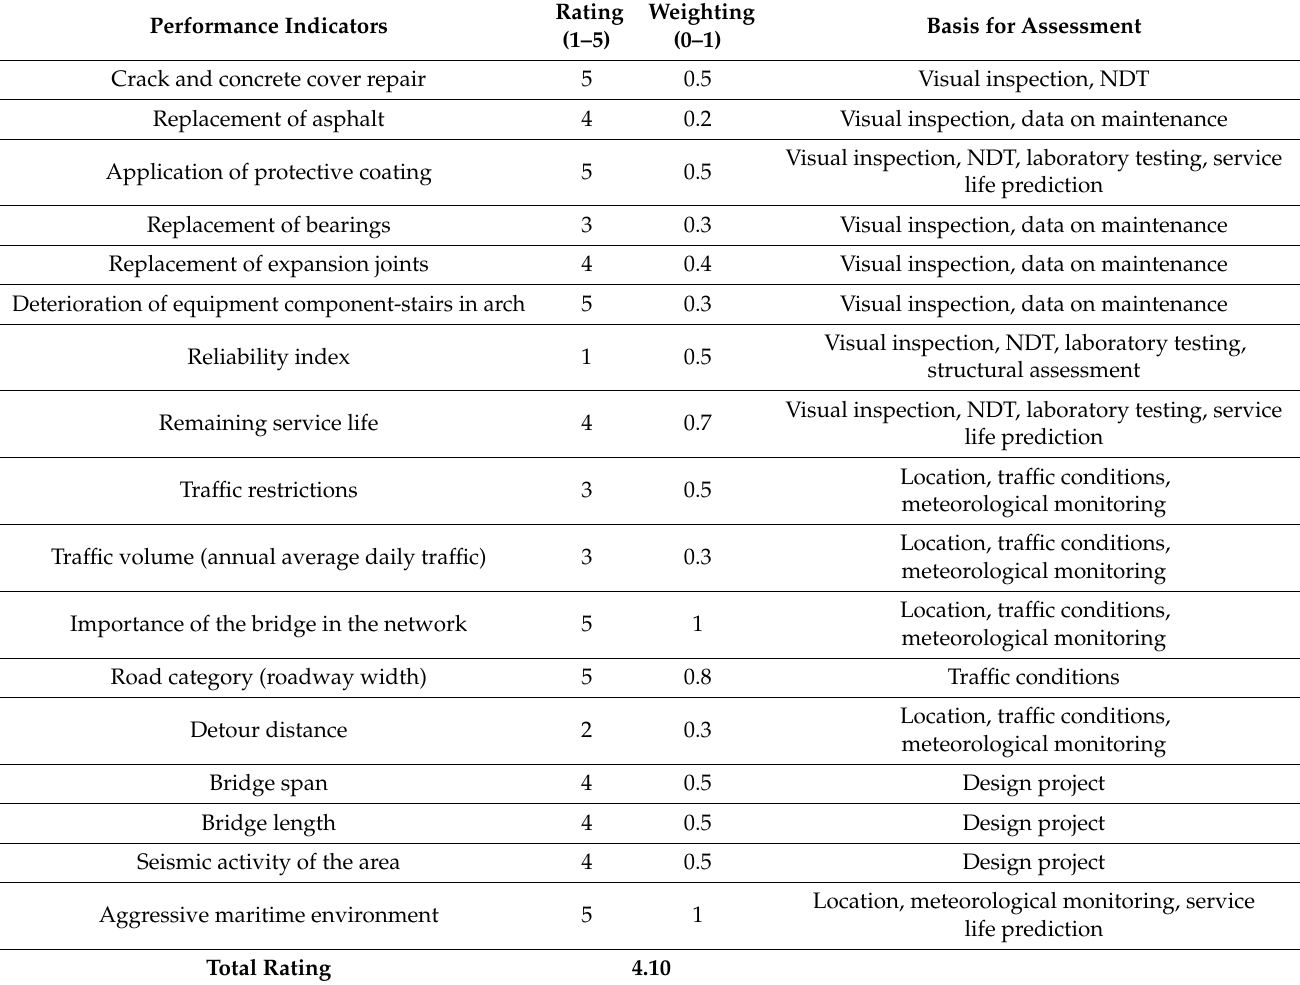
Table 10. Assessment of key performance indicators related to